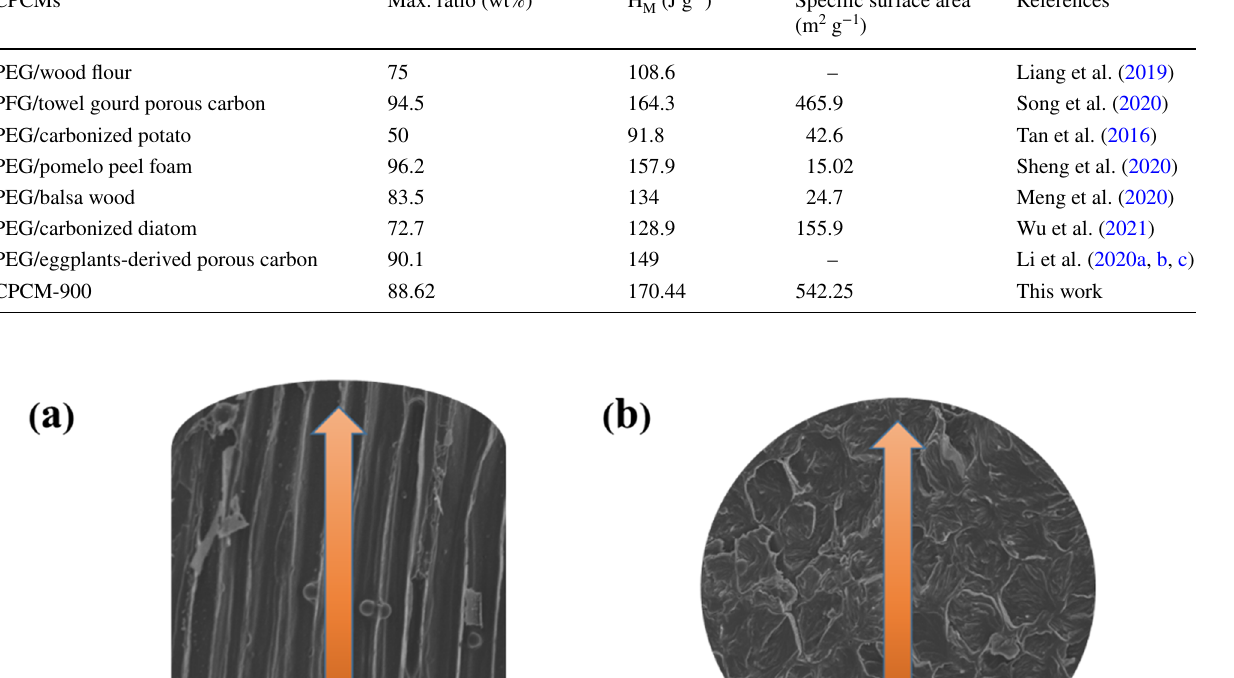
Table 3 Comparison of the thermal properties of the prepared ss-CPCMs and the biomass-based CPCMs previously reported in the literatures CPCMs